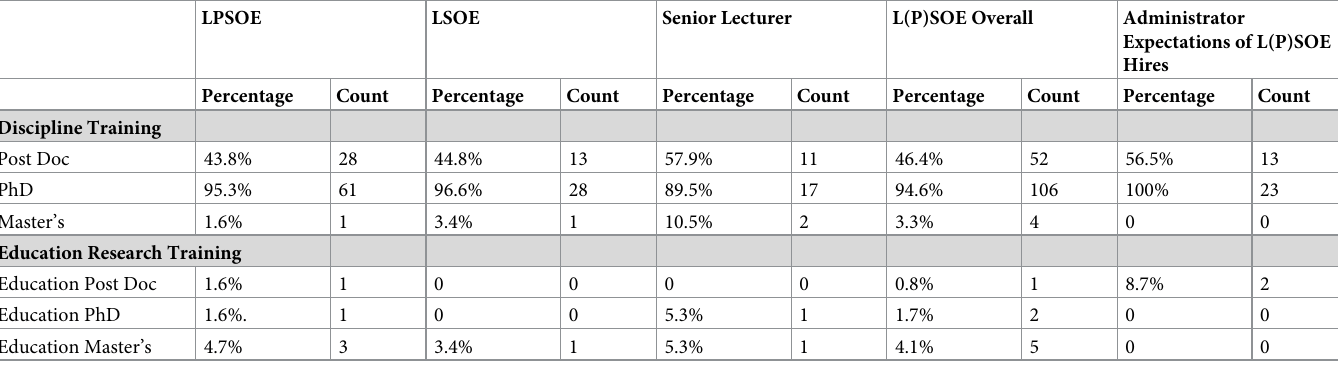
Table 2. L(P)SOE faculty formal discipline and education